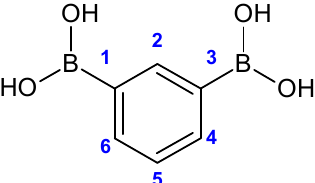
Figure 3. Atom numbering scheme for 1,3-phenylenediboronic acid